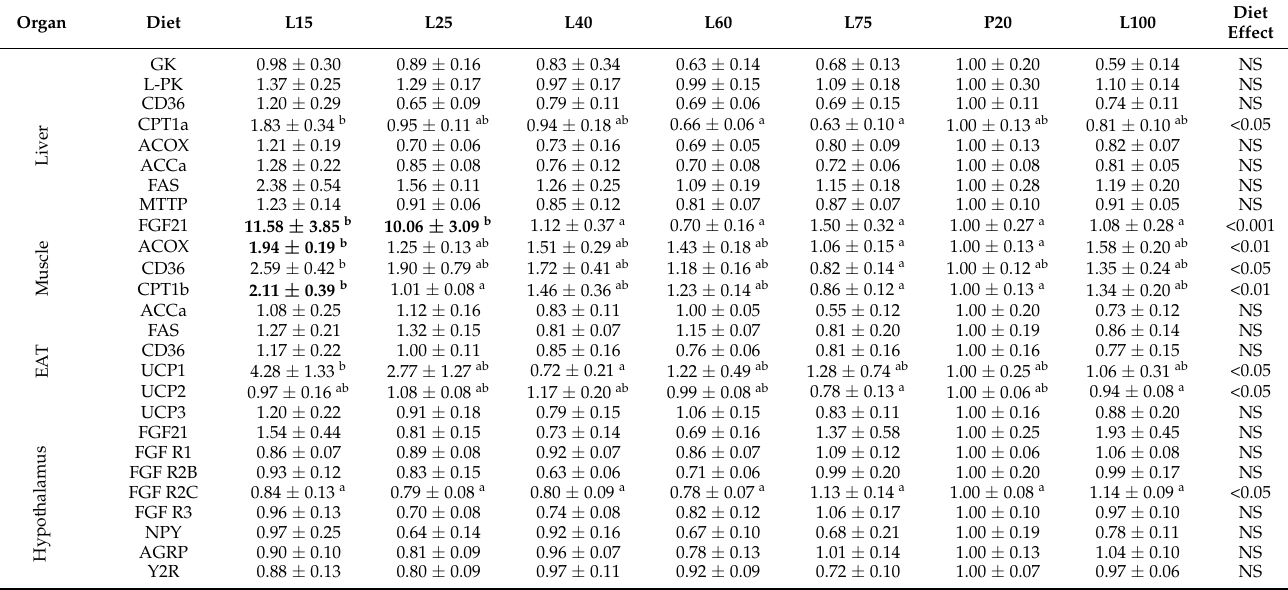
Table 5. Absolute relative expression of mRNA as determined by RT-qPCR for lysine